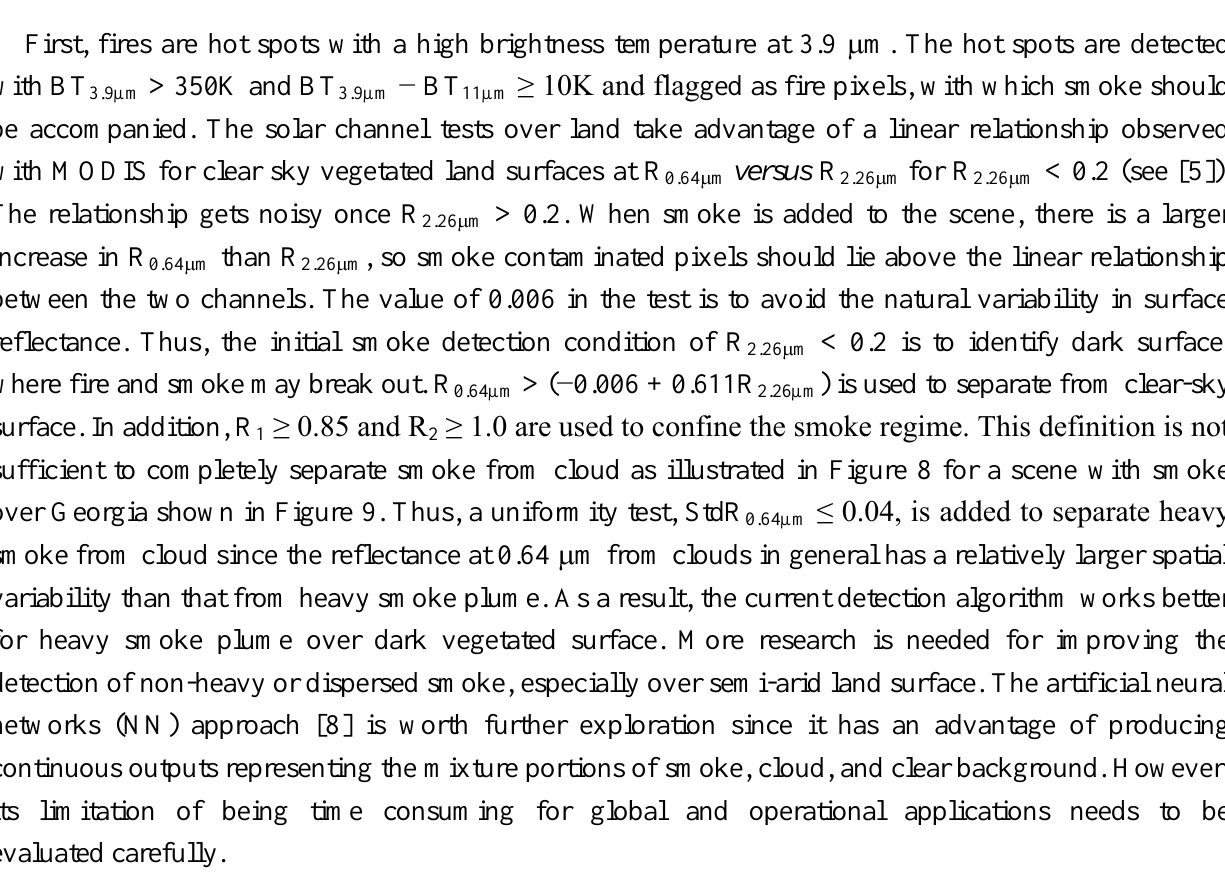
= R /R versus R = R /R for clear-sky 2 0.86  m 0.64  m 1 0.47  m 0.64  m